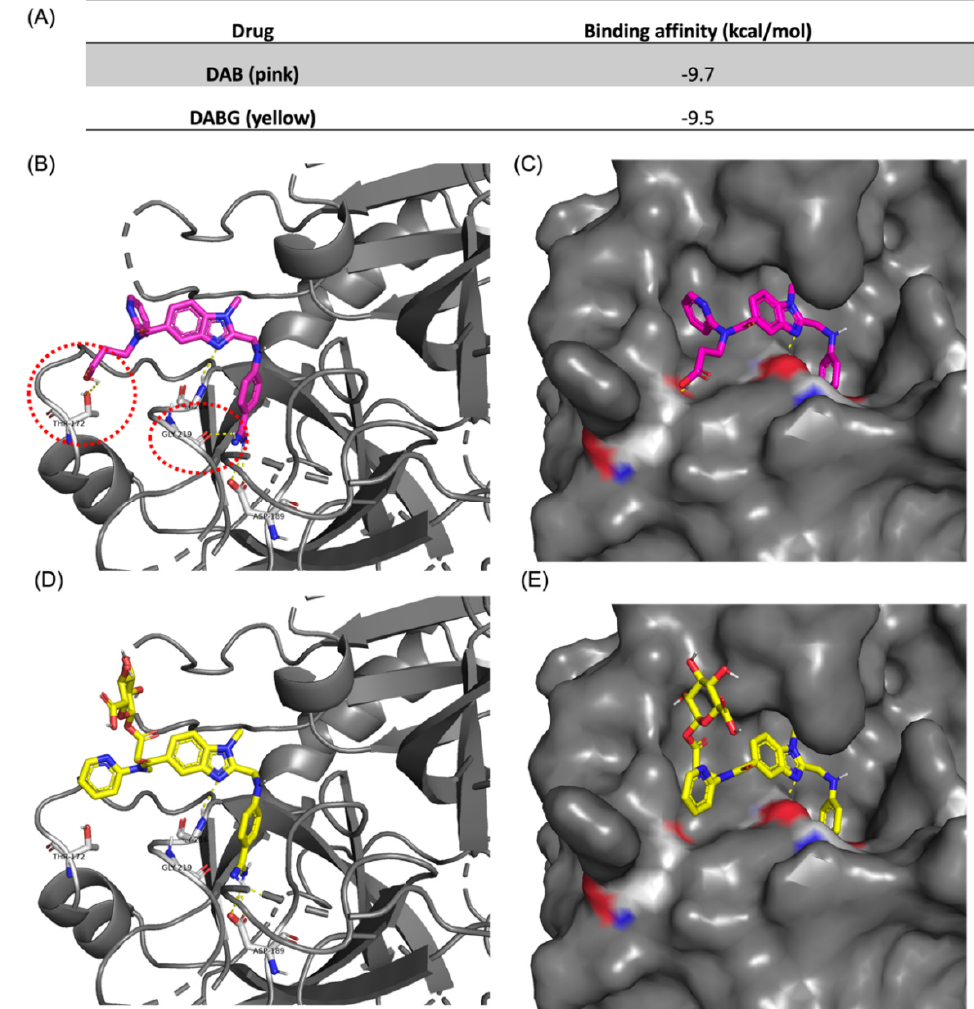
Figure 5. Docking-simulation results between thrombin and ligands. ( A ) Binding affinity energies obtained from the top-hit docking mode of DAB and DABG using Autodock Vina. Docking conformation of DAB with thrombin with ( B ) cartoon plot and ( C ) protein surface plot. Docking conformation of DABG with thrombin with ( D ) cartoon plot and ( E ) protein surface plot. Docking results and hydrogen bonding were visualized using PyMOL (v2.3.5).